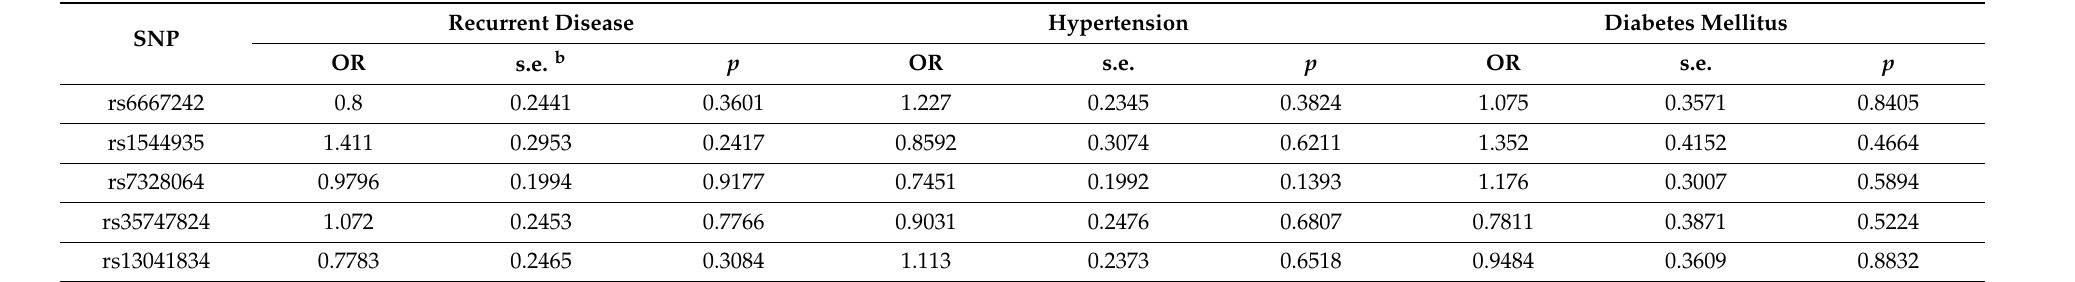
Table 3. Multiple logistic regression analyses for clinical